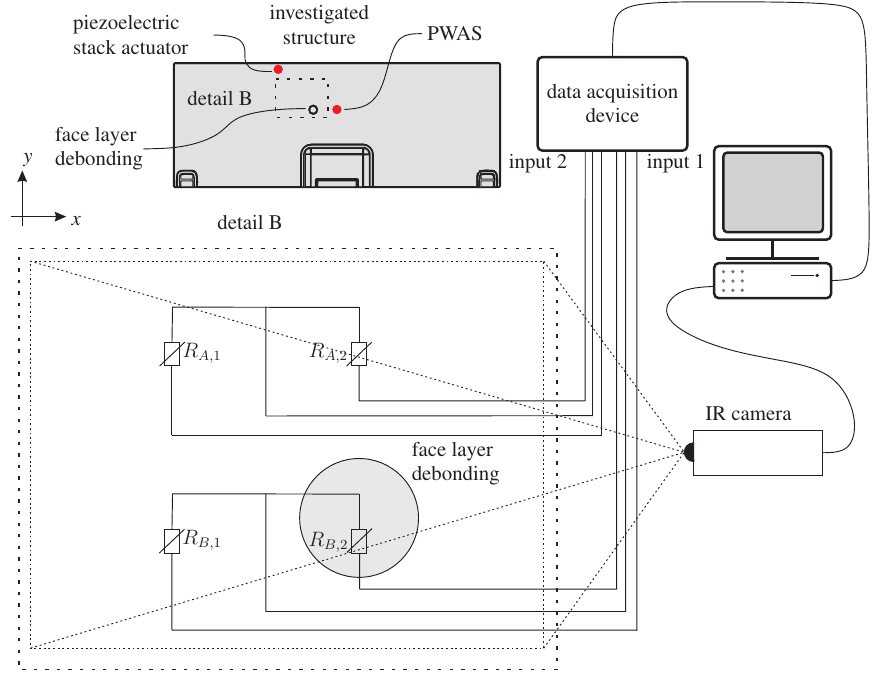
Figure 4. Experimental set-up of the temperature-based damage identification experiment (detail B is a scaled magnification of the area of